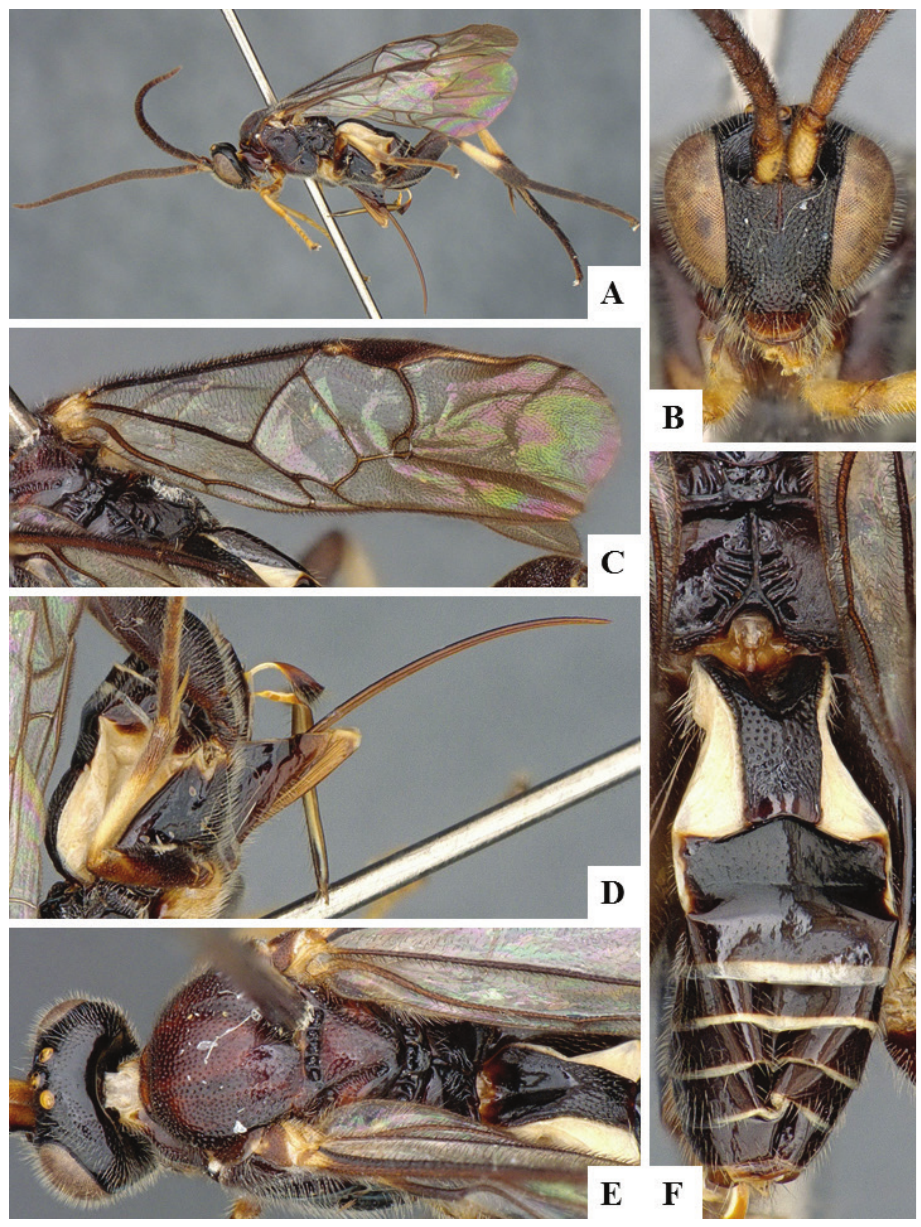
Figure 4. Agupta jeanphilippei female holotype. A Habitus B Head frontal C Fore wing D Ovipositor and ovipositor sheaths E Head and mesosoma, dorsal F Propodeum and metasoma, dorsal. Diagnosis. The dark brown color of wing veins separates this species from A. solangeae and A. raymondi , both of which have most veins golden-yellow. The body mostly dark brown to reddish-brown will in turn differentiate A. jeanphilippei